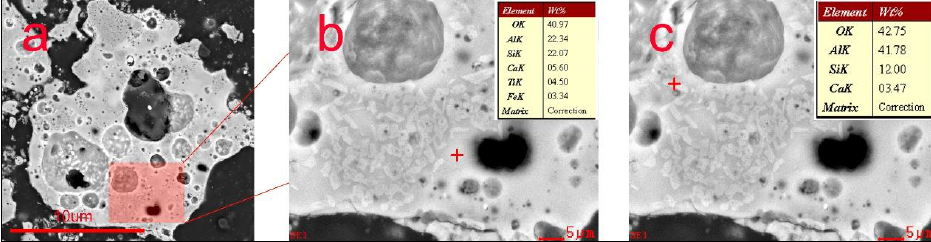
Figure 3. SEM images of HAFA ( a ) and EDX analysis of amorphous phase ( b ) and mullite phase ( c ). Figure 4 shows that the amorphous silicate was in the form of Q 4 (3Al)/Q 4 (2Al)/Q 4 (1Al) coordination structure beside the Q4(0Al), and the Al-O- coordi-